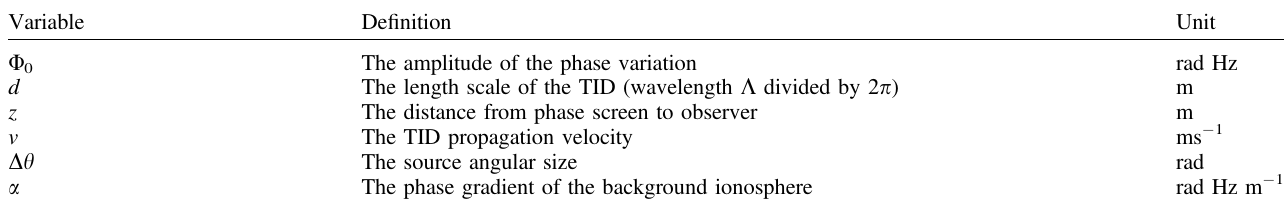
Table 1. The de fi nitions of the variables used in the analytic phase screen